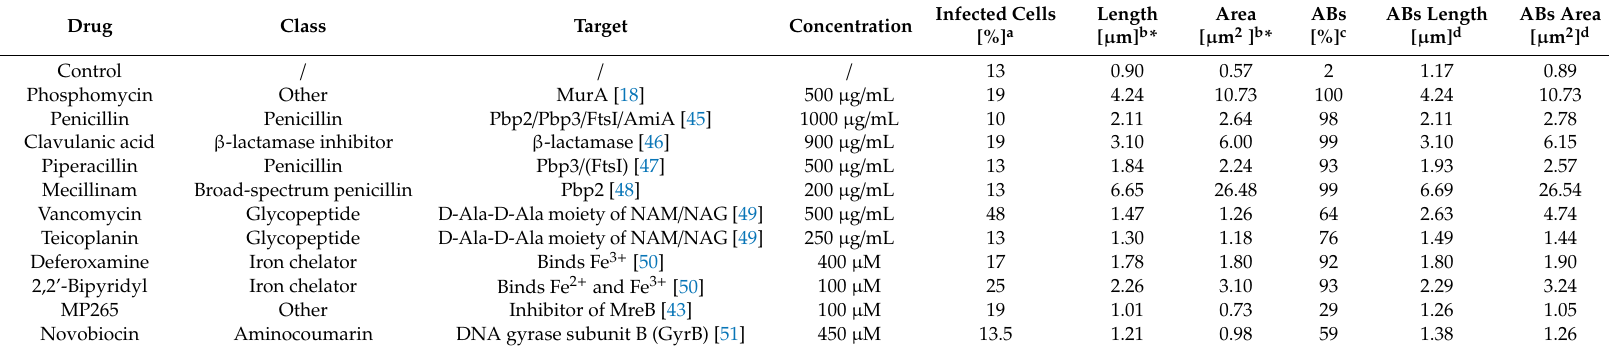
Table 1. Summary of the drugs used in the study and of their e ff ects on the percentage of infected cells as well as on length and area of induced aberrant bodies at 24